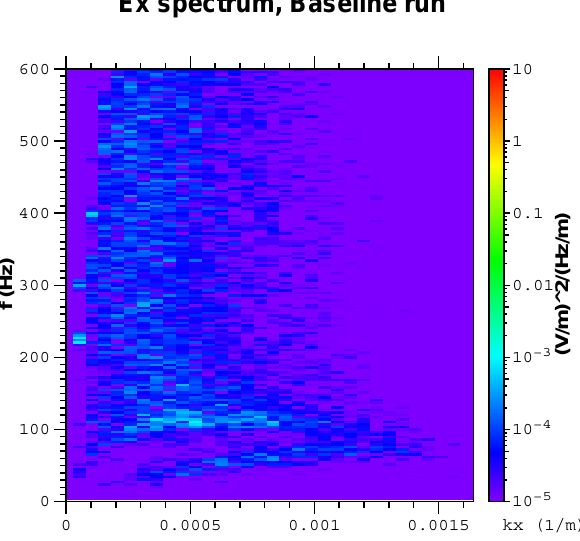
Fig. 8. Spatiotemporal power spectrum as a function of k x and fre- quency of perpendicular electric field E x in the baseline run.